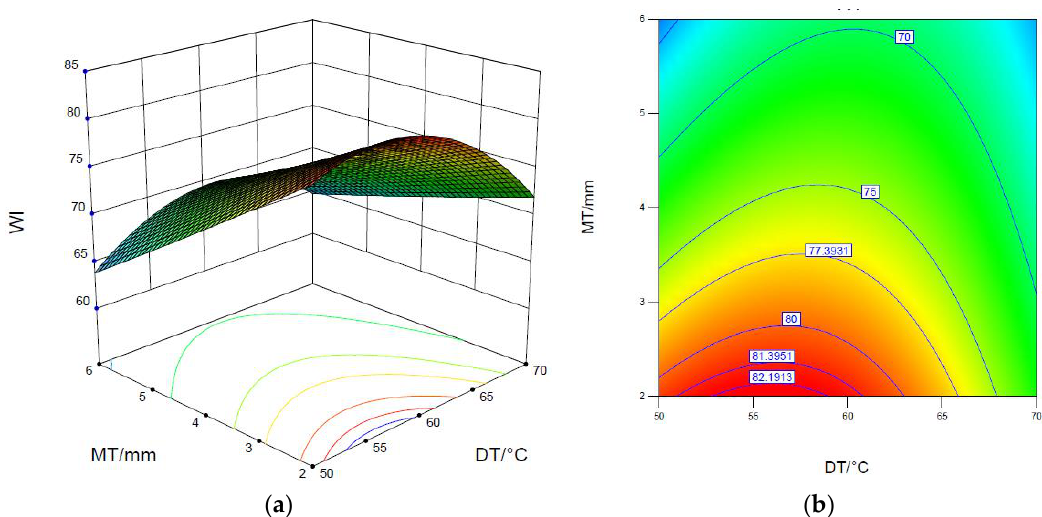
Figure 7. Response surface ( a ) and contour ( b ) for WI with respect to interaction term of DT•MT at a constant drying vacuum of 0.06 MPa.